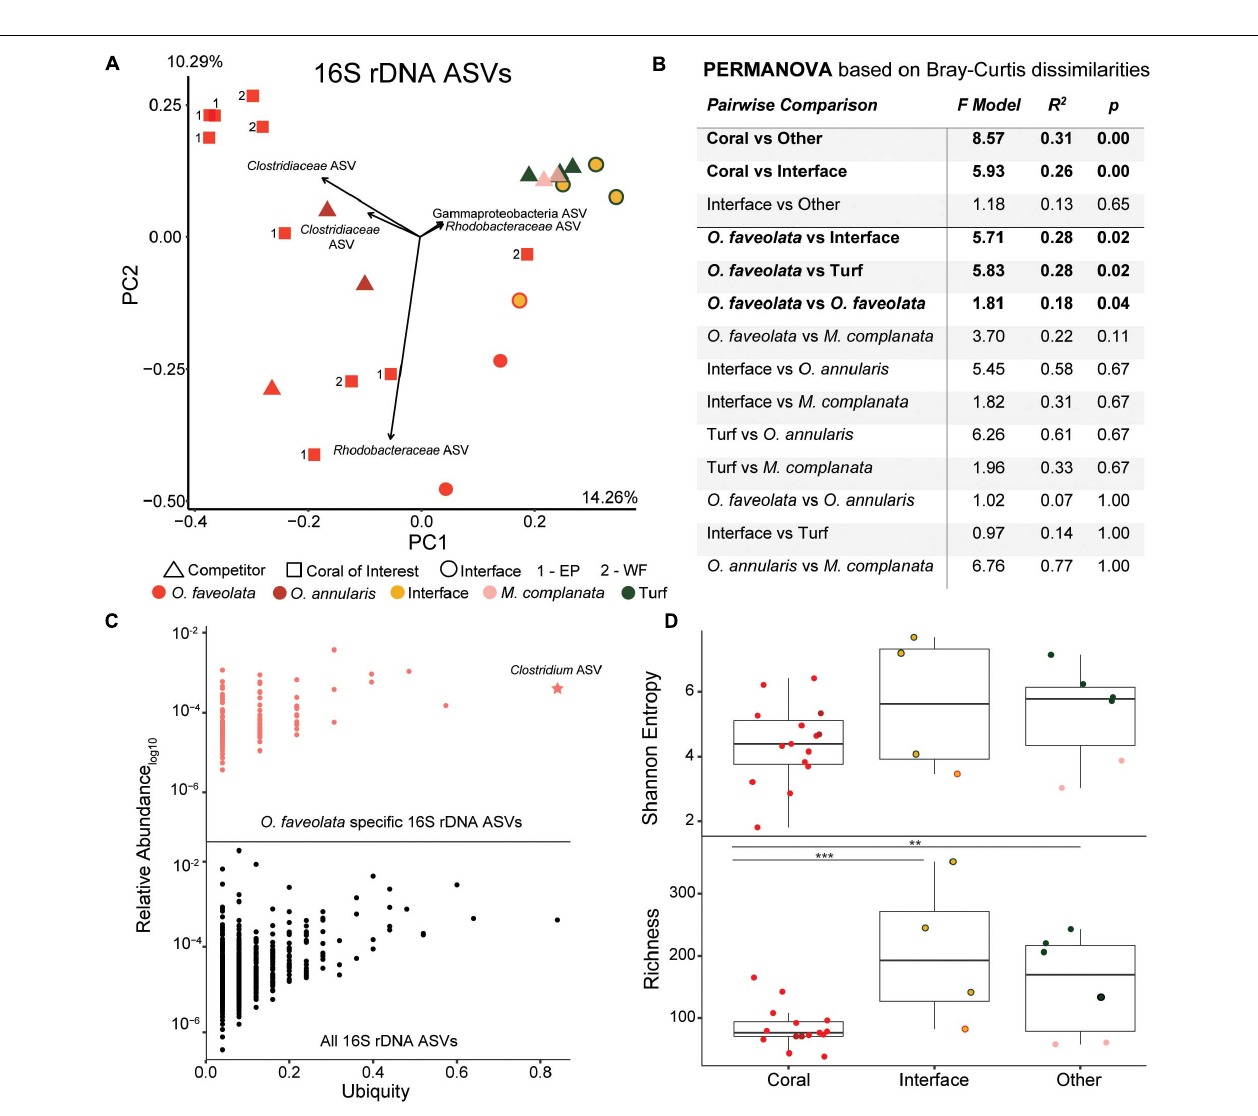
FIGURE 3 | Overview of the 16S rDNA amplicon data. (A) Principal components plot of the 16S rDNA ASVs from the coral colonies of interest along with interfaces and their respective benthic competitors. EP, East Point coral of interest; WF, Water Factory coral of interest. (B) PERMANOVA results based on Bray-Curtis dissimilarities. (C) Relative abundance (proportion of the entire community) versus ubiquity of each ASV from all samples (bottom plot) and those unique to O. faveolata samples (top plot). Ubiquity for unique O. faveolata ASVs is normalized to total O. faveolata samples. The star represents the most ubiquitous ASV found only in O. faveolata (i.e., a taxa that is uniquely ubiquitous in O. faveolata ). (D) Diversity metrics of coral, interface and other (turf algae and M. complanata ) samples. Interface and other samples had significantly higher bacterial richness than coral samples (** p ≤ 0.01, *** p ≤